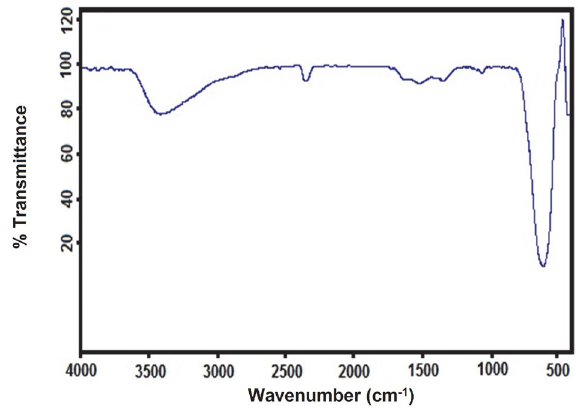
Fig. 1. FT-IR spectra of NiFe 2 O 4 nanoparticles